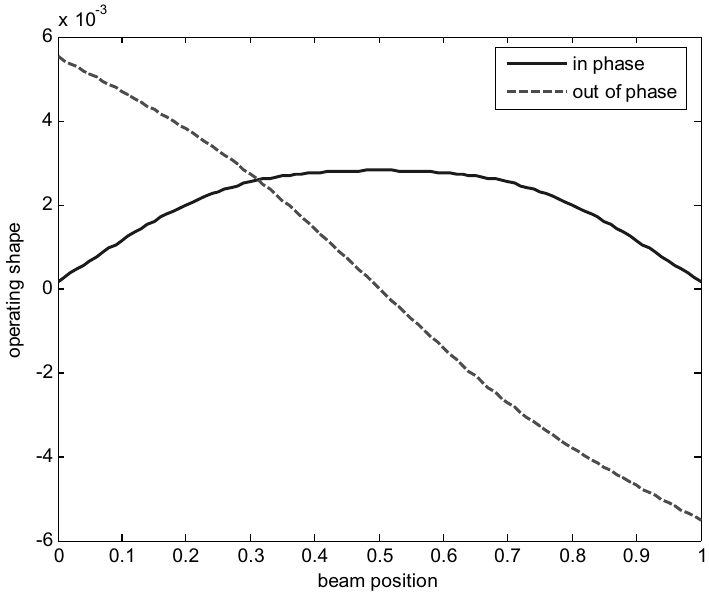
Fig. 16. Example 3, Operating shape near 147